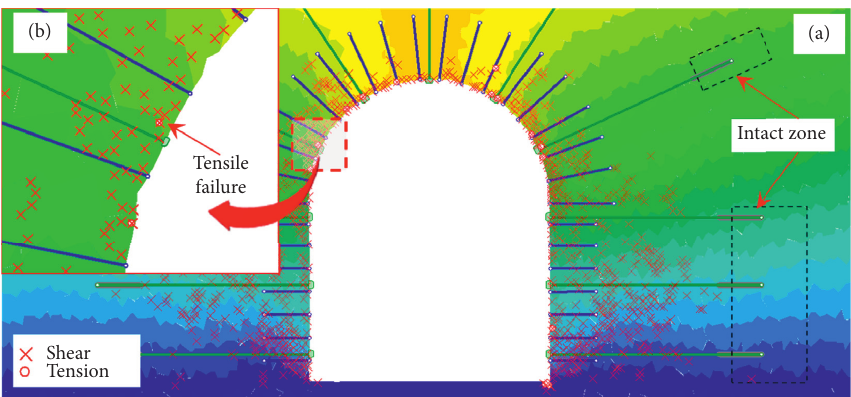
Figure 1: Plasticity characteristics of the